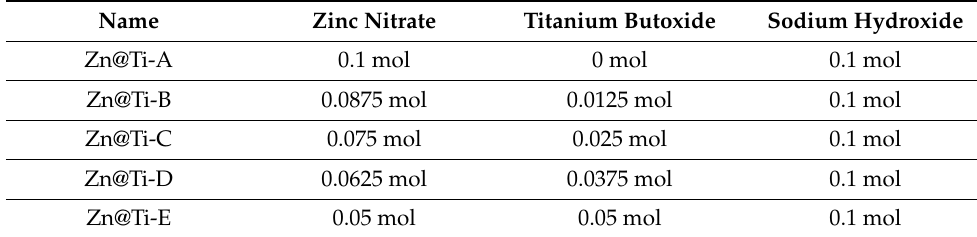
Table 3. Synthetic conditions of Zn-Ti oxide